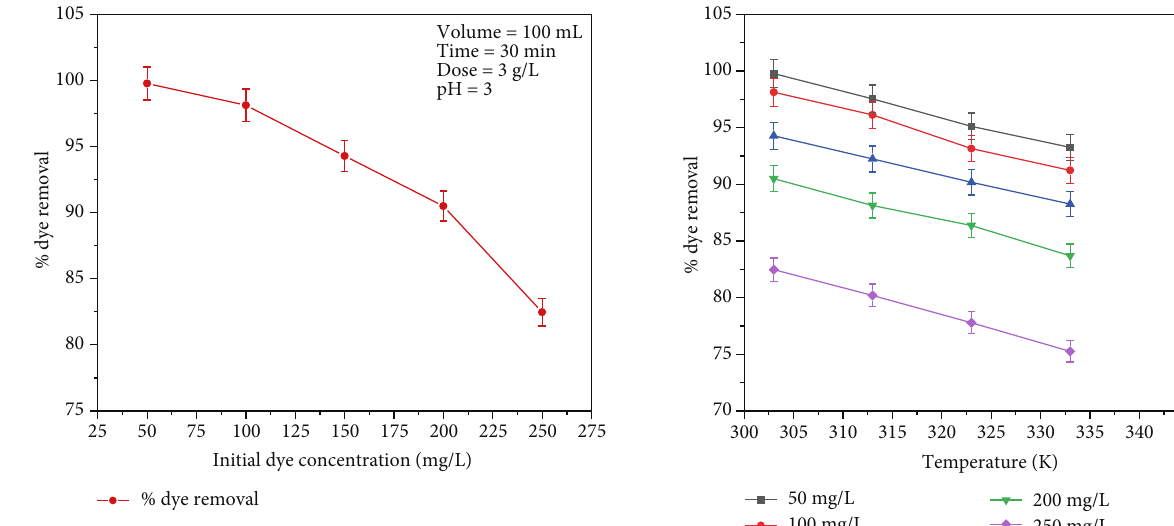
Figure 9: Removal of ARS dye at various initial concentrations.